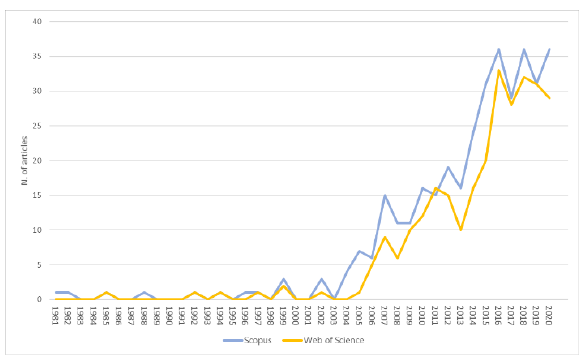
Figure 8 . Published scientific literature according to those keywords’ combinations in Figure 2 (1981-2020).